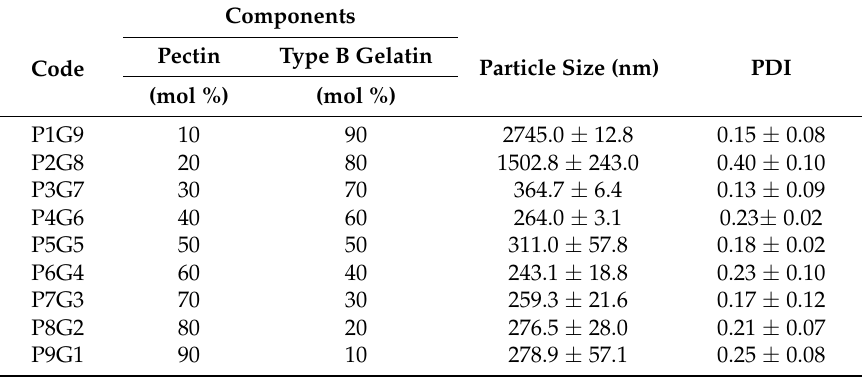
Table 1. The particle size and distribution of the PECs containing various ratios of constituents (to a final concentration of 1